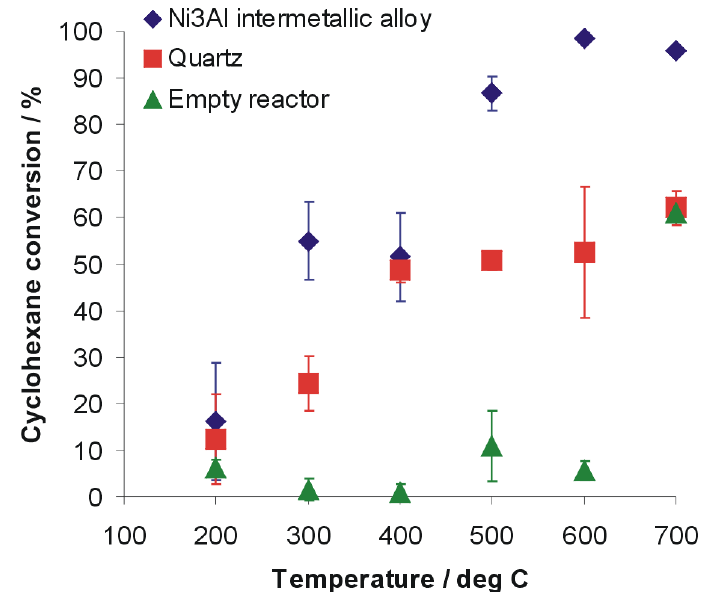
Figure 1. Conversion of cyclohexane conducted on the pieces of Ni 3 Al thin foil, quartz and empty reactor as a function of the